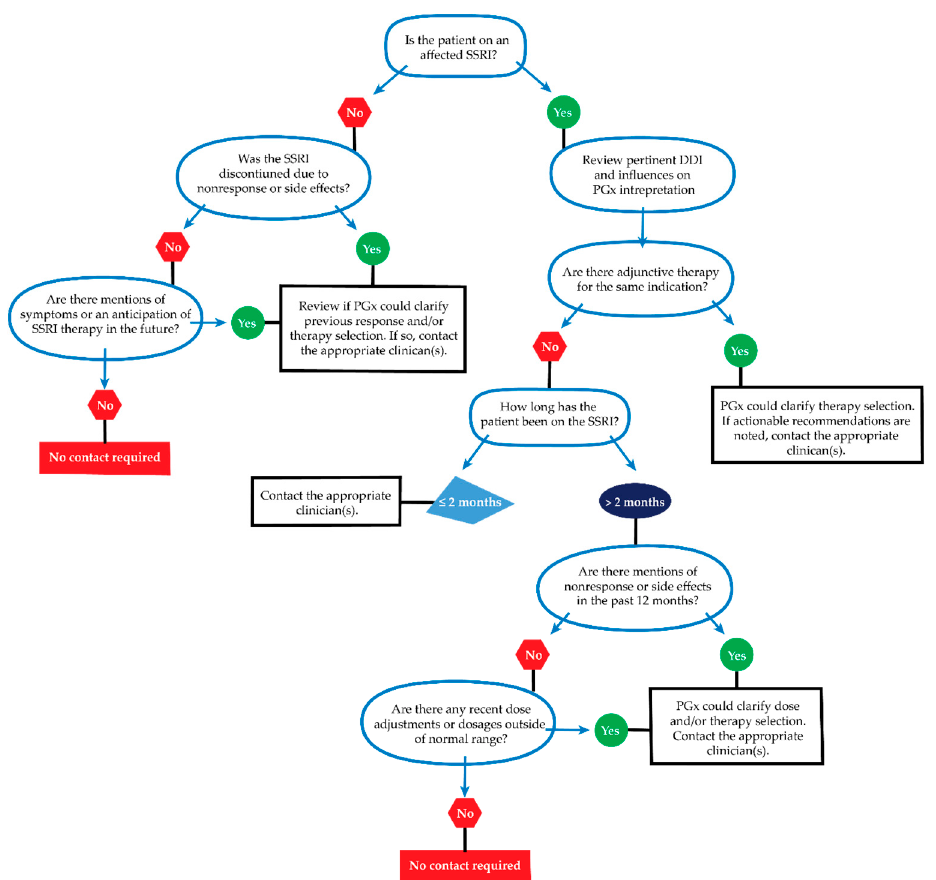
Figure 2. Clinician contact decision tree for actionable SSRI reinterpretations. The programmatic reprocessing effort flagged patient records with evidence of new actionable reinterpretations and SSRI prescription. Patient records were reviewed using this workflow to determine the appropriateness of clinician contact.